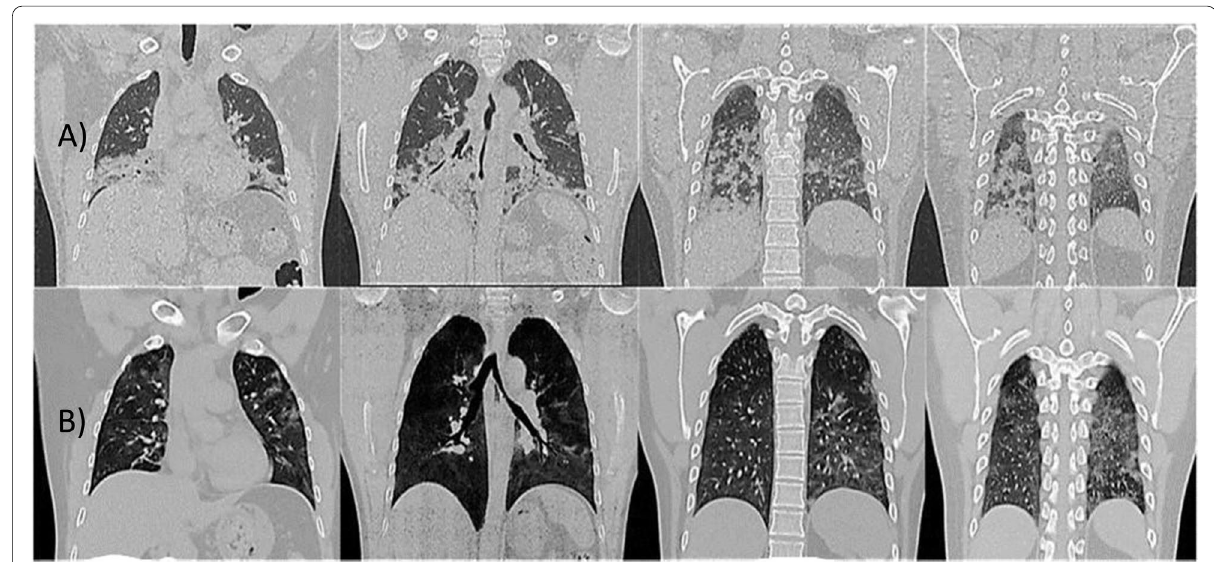
Fig. 6 High‑Resolution Computer Tomography Scans Images of a Patient’s Chest. Legend: Patient No. 4. Group A (peripheral blood non‑hematopoietic enriched stem cell cocktail standard care): Images a) Day of recruitment (April 1st). Images b) Four days after the first dose of + stem cell treatment (April 13th, nebulization was initiated on April 9th, and the second dose was commenced on April